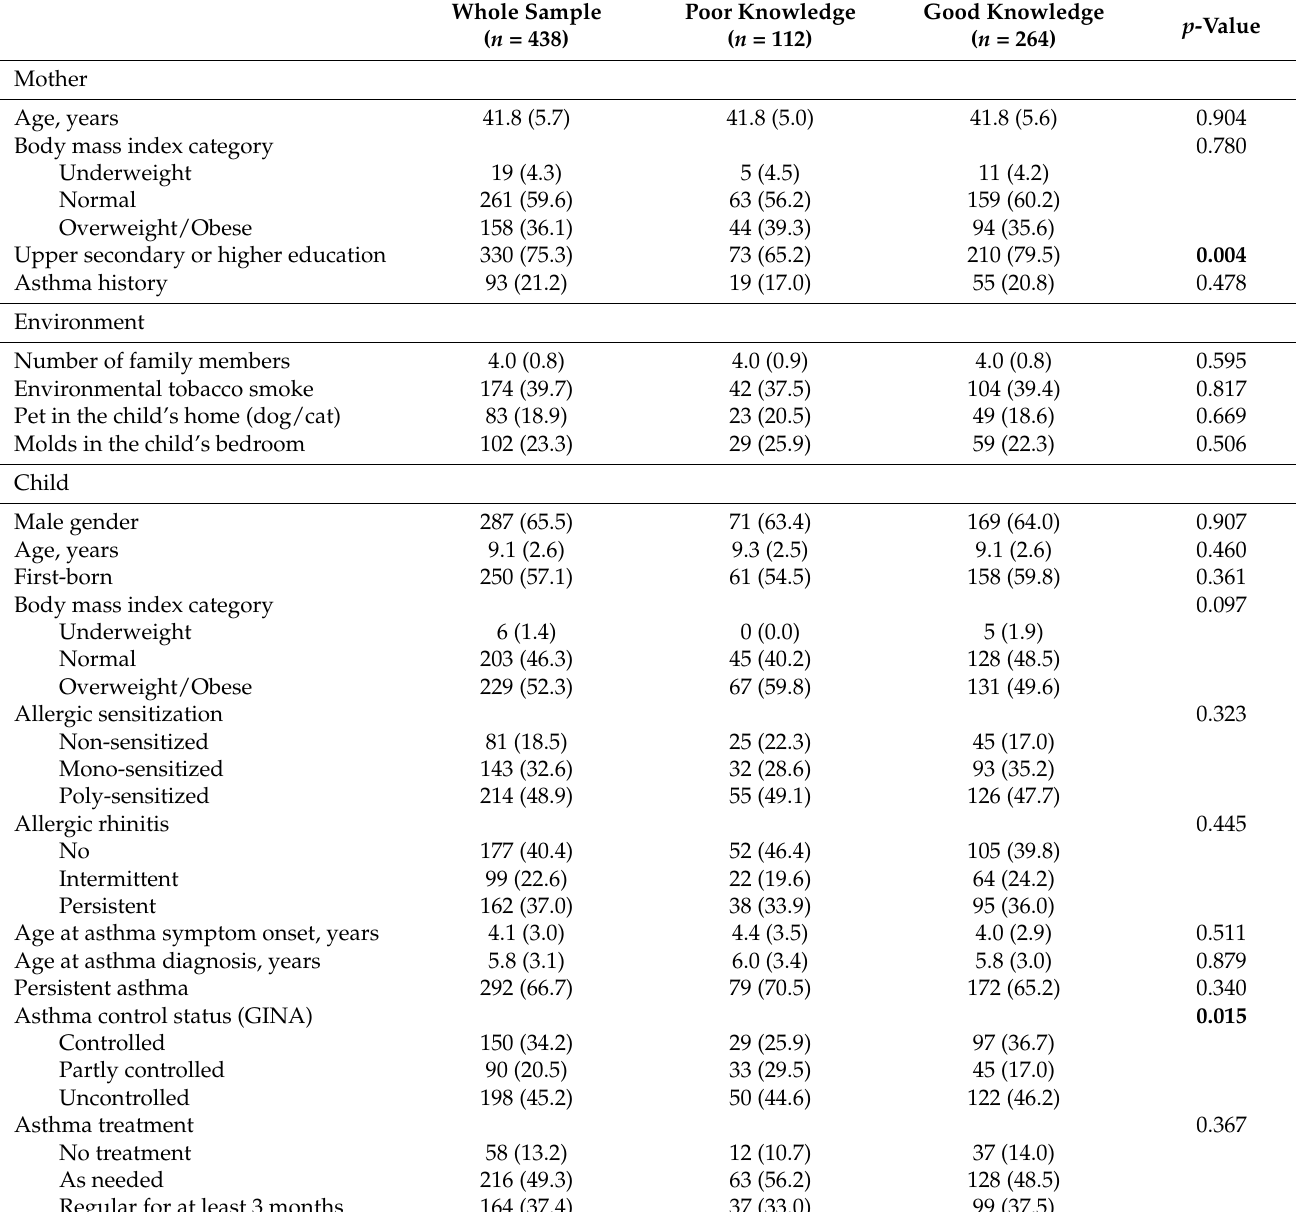
Table 1. Distribution of mother and child characteristics in the whole sample and by class membership (mothers classified with an assignment probability of at least 0.90). Data are expressed as means (SD) for quantitative variables, and n (%) for categorical variables. Significant p -values are in